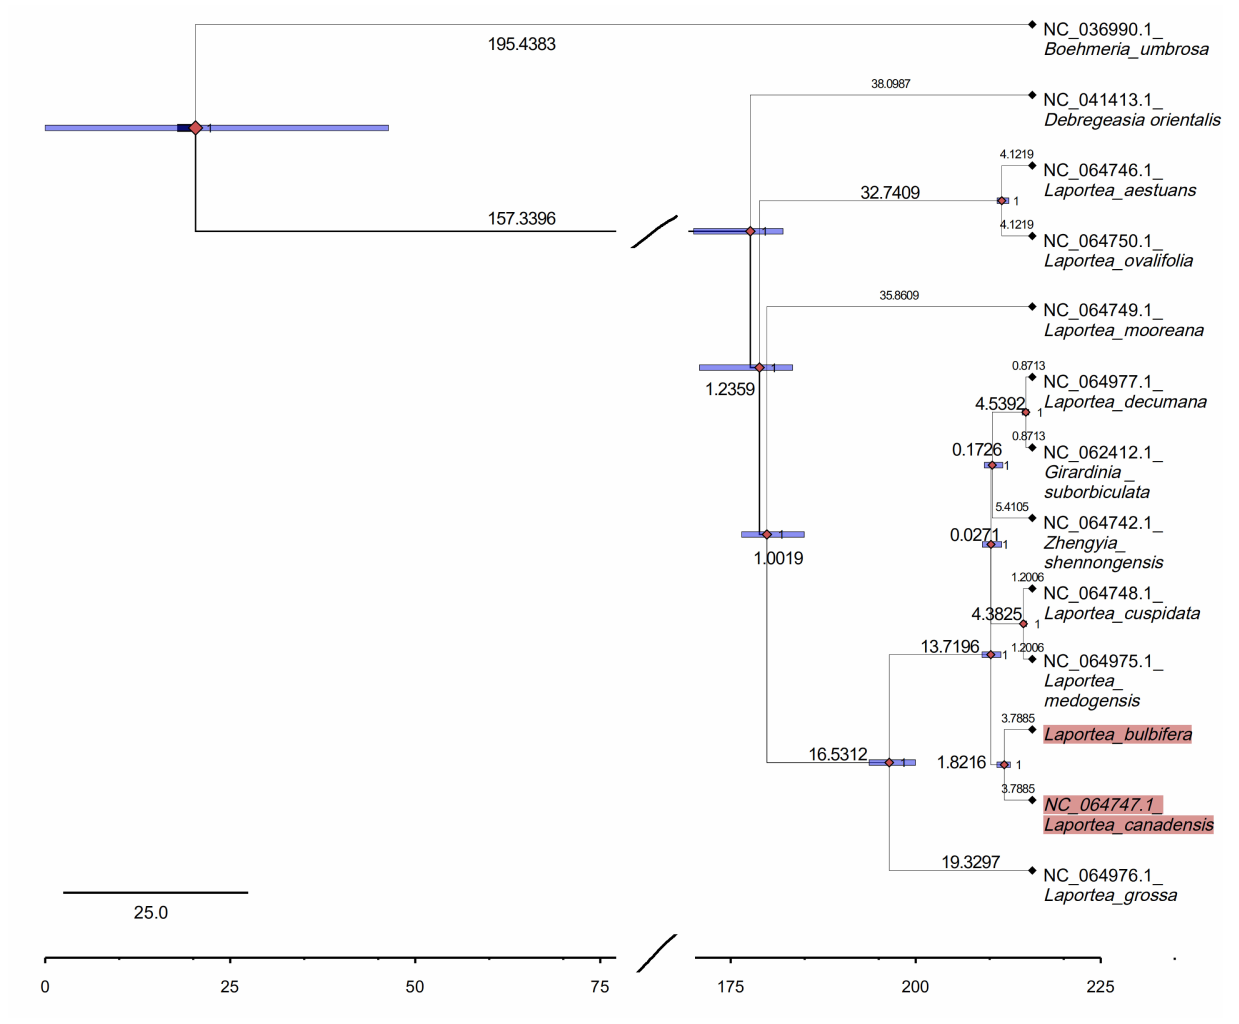
Figure 8. Divergence time estimation. The phylogenetic tree was reconstructed based on 78 CDSs by using the maximum likelihood (ML) methods and the bars show the 95% highest posterior density on the age estimates. The red highlighted part indicates the closest relationship between L. canadensis and L. bulbifera , and probably splitting at~1.8216